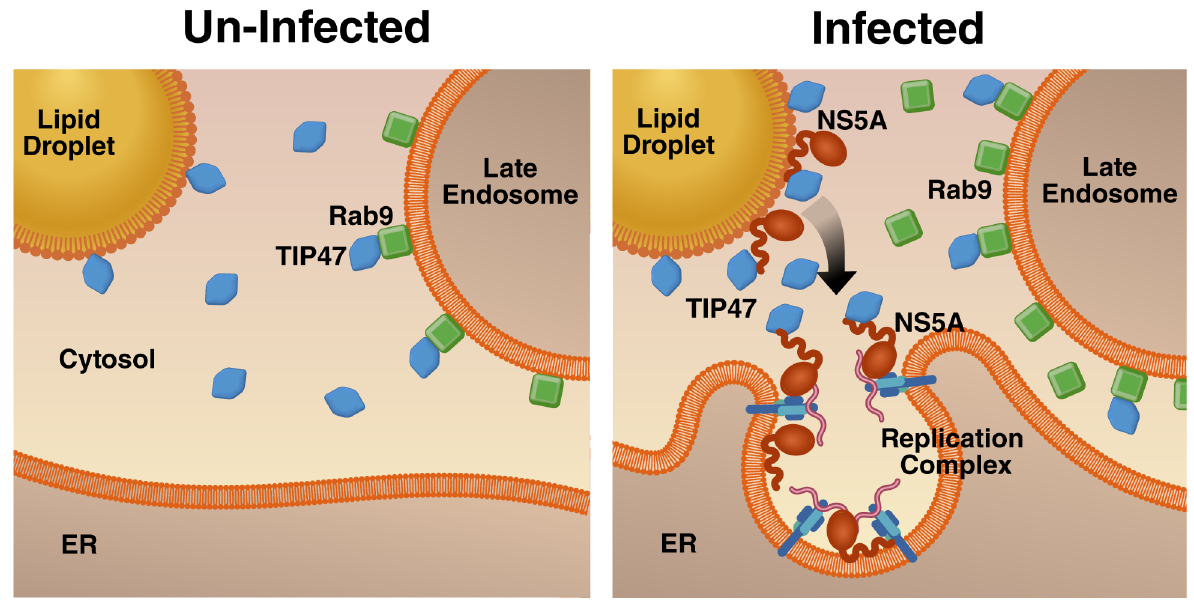
Figure 6. Model: TIP47 recruits LD membranes to the membranous web via interaction with NS5A. In uninfected cells : TIP47 is involved in the retrograde trafficking pathway by interacting with Rab9 at late endosomes, and functions as an ‘‘exchangeable’’ LD-associated protein that is mostly present in the cytosol but moves to LDs upon rapid fat storage. In HCV-infected cells : TIP47 interacts with NS5A-containing replication complexes at the ER and NS5A at LDs, thus making LD membranes accessible for HCV RNA replication for either integration of LDs into the membranous web, or as source of energy for the creation of the membranous web. HCV infection also increases endosome-to-Golgi trafficking via the up-regulation of Rab9